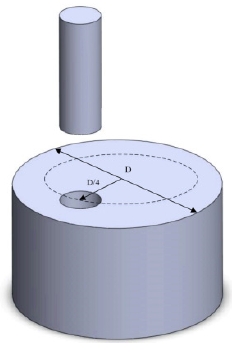
Figure 2. Original microstructure of TC10 alloy bars.